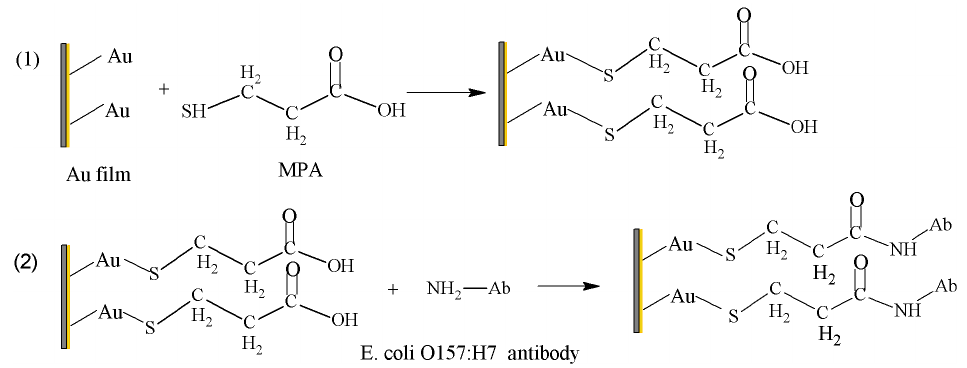
Figure 2. Schematic diagram of the procedure of Escherichia coli O157:H7 biomolecular recognition membrane. (1) A 3-MPA SAM was first attached to the biosensor surface; (2) The E. coli O157:H7 antibody molecules were immobilized on the sensor surface.